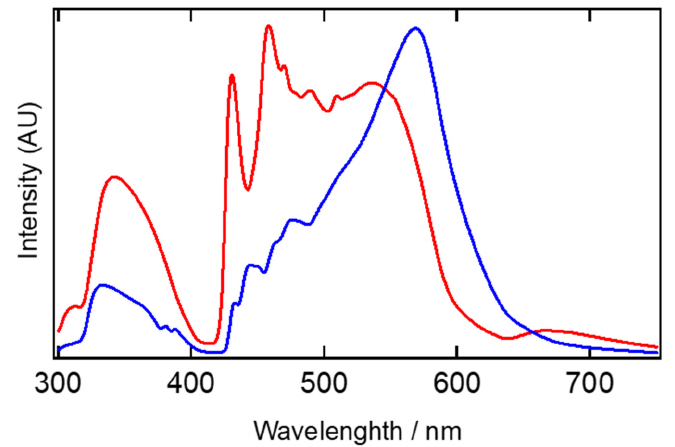
Figure 6. Solid ‑ state photoluminescence spectra of [Cu( μ -L5)] 3 (red line) and [Cu( μ -L6)] 3 (blue line) at 83 K recorded at 280 nm